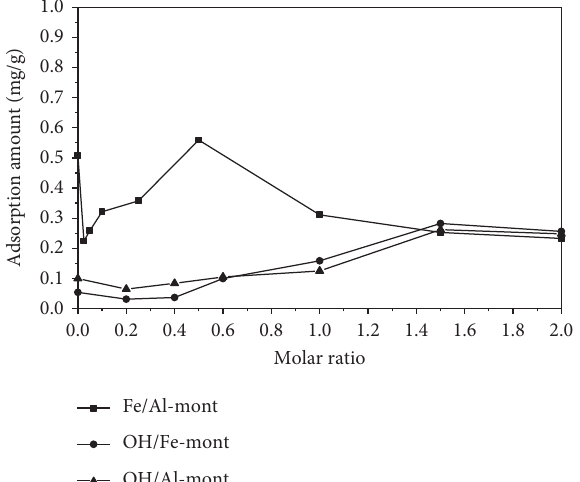
Figure 10: Effect of varying the OH/Fe, OH/Al, and Fe/Al molar ratios on the ZEA adsorption capacity.